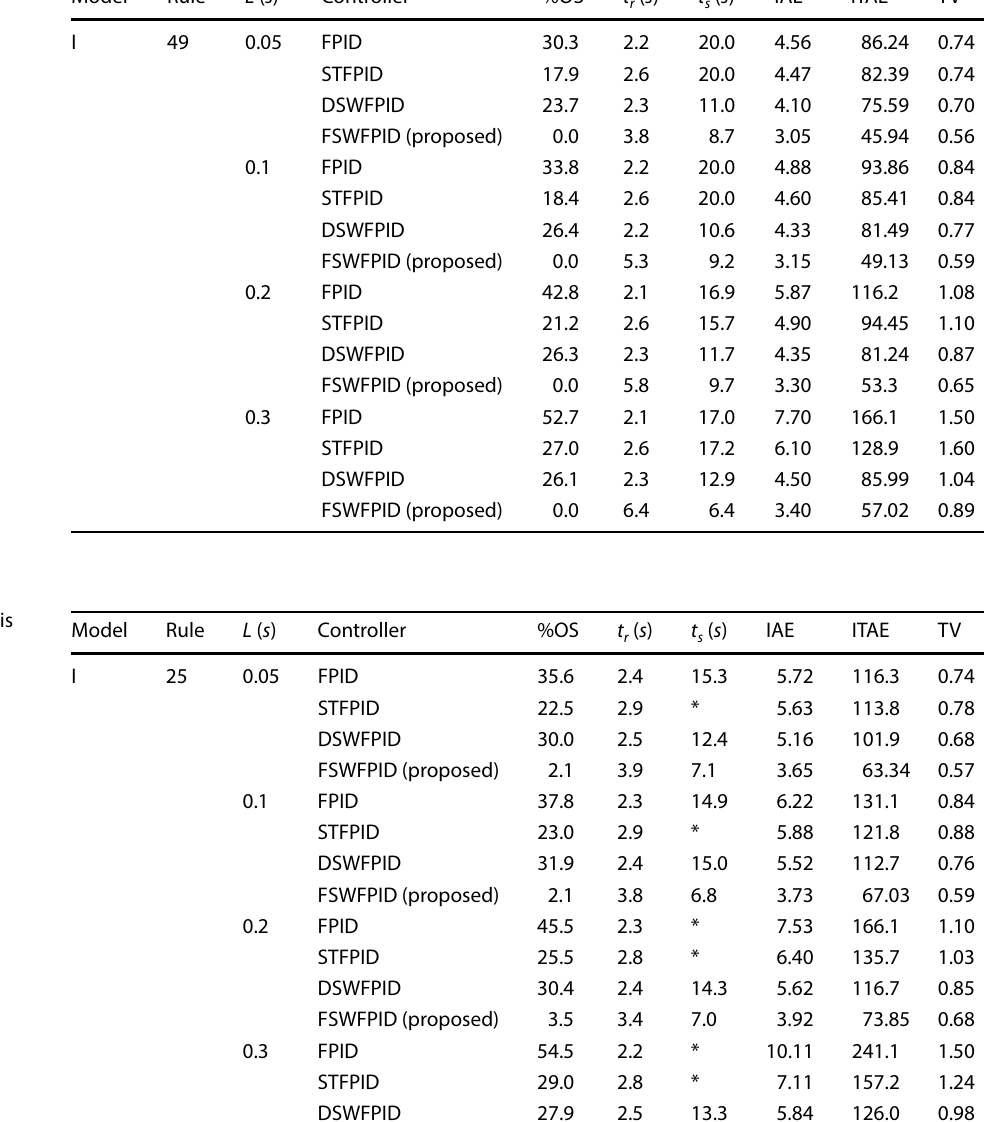
Table 4 Performance analysis for Model I